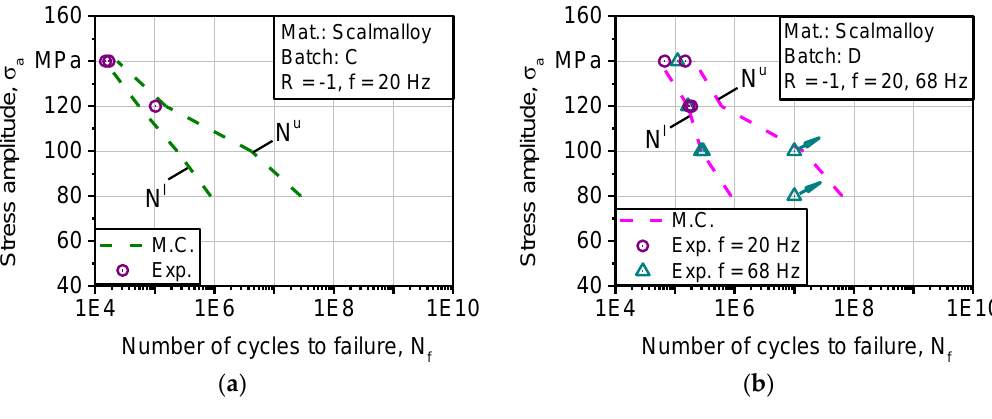
Figure 15. Comparison between calculated and experimental fatigue strength of batches: ( a ) C (Scalmalloy ® LMD); ( b ) D (Scalmalloy ® SLM).